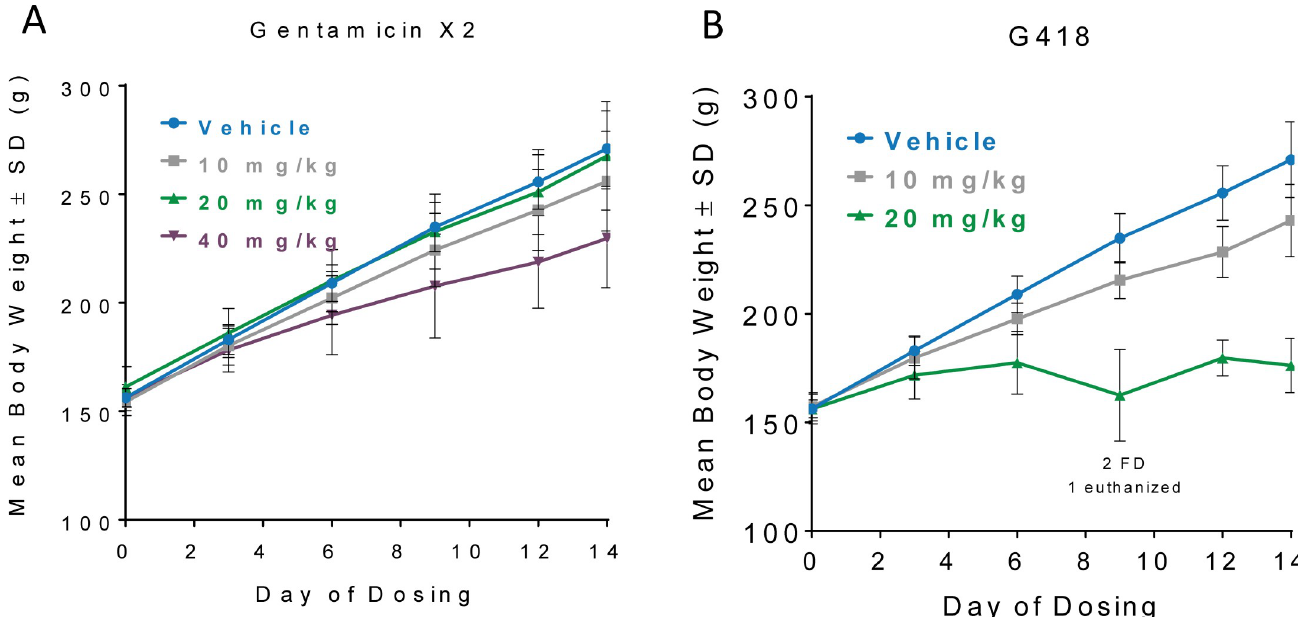
Fig 4. Gentamicin X2 was better tolerated than G418. When administered at a dose of 20 mg/kg G418 (A) caused a greater decrease in body weight than did gentamicin X2 (B) when administered at a dose of 40 mg/kg. Rat body weights can be found in S1 Table.